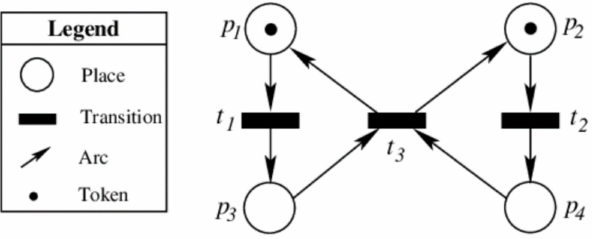
Figure 2. Example of a Petri